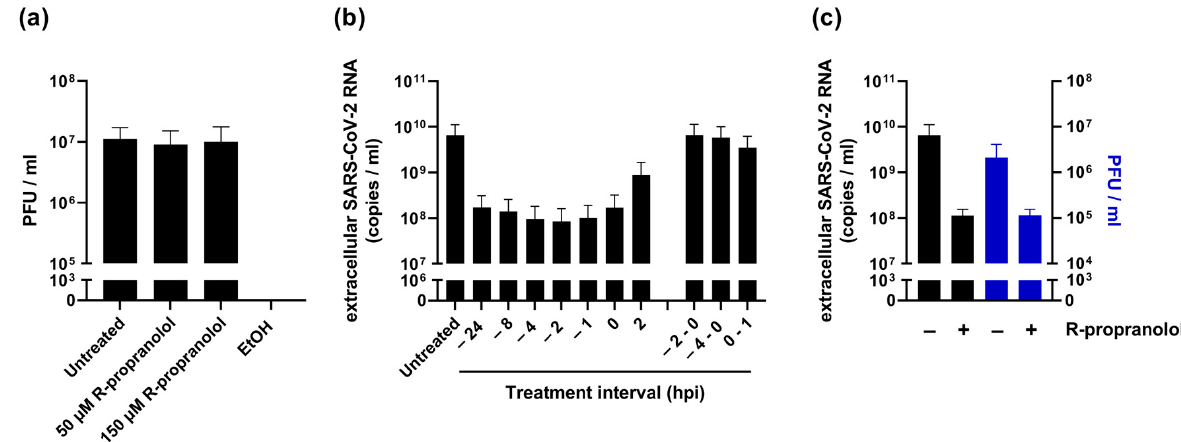
Figure 5. R-propranolol inhibits the replication of SARS-CoV-2 at a post-entry step. ( a ) Effect of the compound on infectivity of SARS-CoV-2. Virus was incubated with either 50 or 150 µ M R-propranolol, 70% ethanol, or medium (untreated control) for 1 h at 37 ◦ C. Remaining infectivity was measured by plaque assay. n = 3 independent experiments. ( b ) Time-of-addition assay with Vero E6 cells infected at MOI 1 and R-propranolol treatments during the time intervals indicated on the x -axis or initiated at the indicated time points, all relative to the time of infection (t = 0). Compound remained present until 16 hpi when supernatant was harvested for quantification of extracellular viral RNA by RT-qPCR. n = 2 independent experiments. ( c ) Supernatant of infected Vero E6 cells at 16 hpi, untreated or treated with 50 µ M R-propranolol, was analyzed by RT-qPCR and plaque assay. Mean ± SEM of 3 independent experiments is shown.